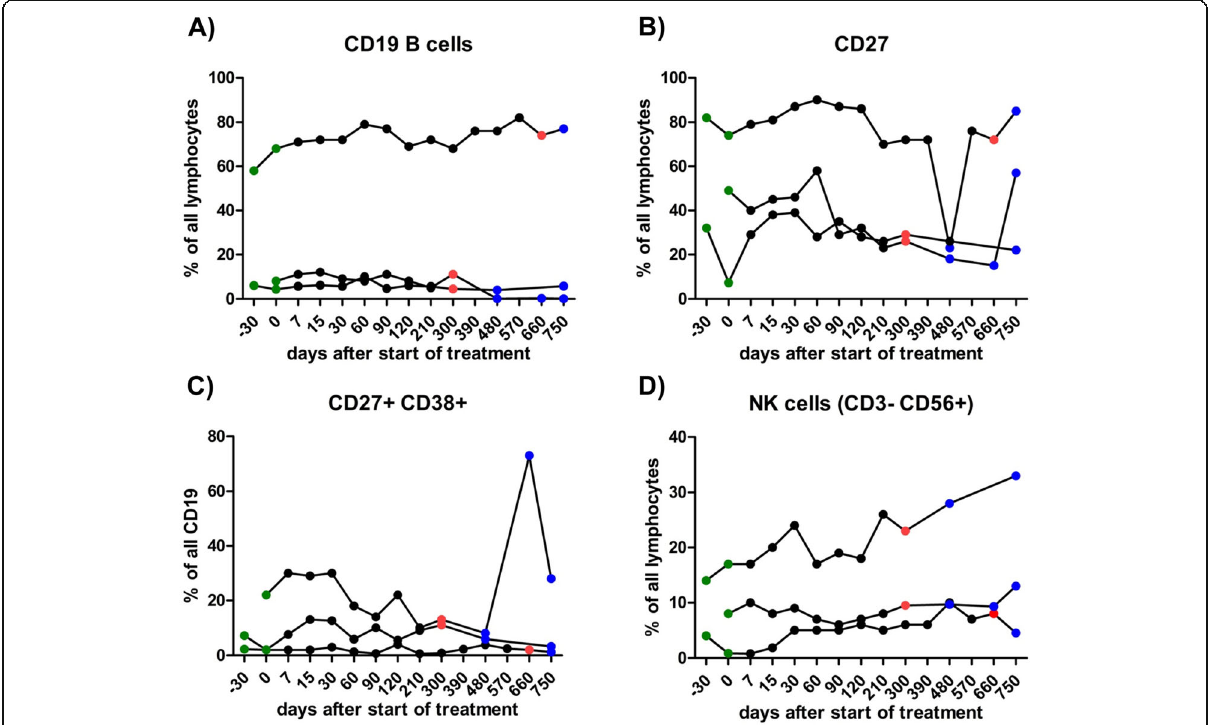
Fig. 3 Frequency of B lymphocytes, plasma cells and NK cells. Frequency of CD19+ B lymphocytes, CD19 + CD38+ plasma cells, CD19 + CD27+ memory B cells and CD56+ NK cells did not significantly differ during treatment of ATRA (Friedman test with Dunn ’ s post-hoc test p